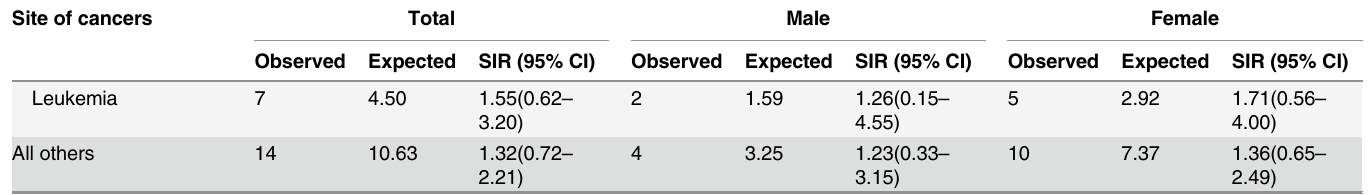
S1 Table. Characteristics of patients after exclusion of inflammatory disease. (DOC) S2 Table. Standardized incidence ratios (SIRs) according to sex, age at diagnosis and dura- tion of follow-up after excluding inflammatory